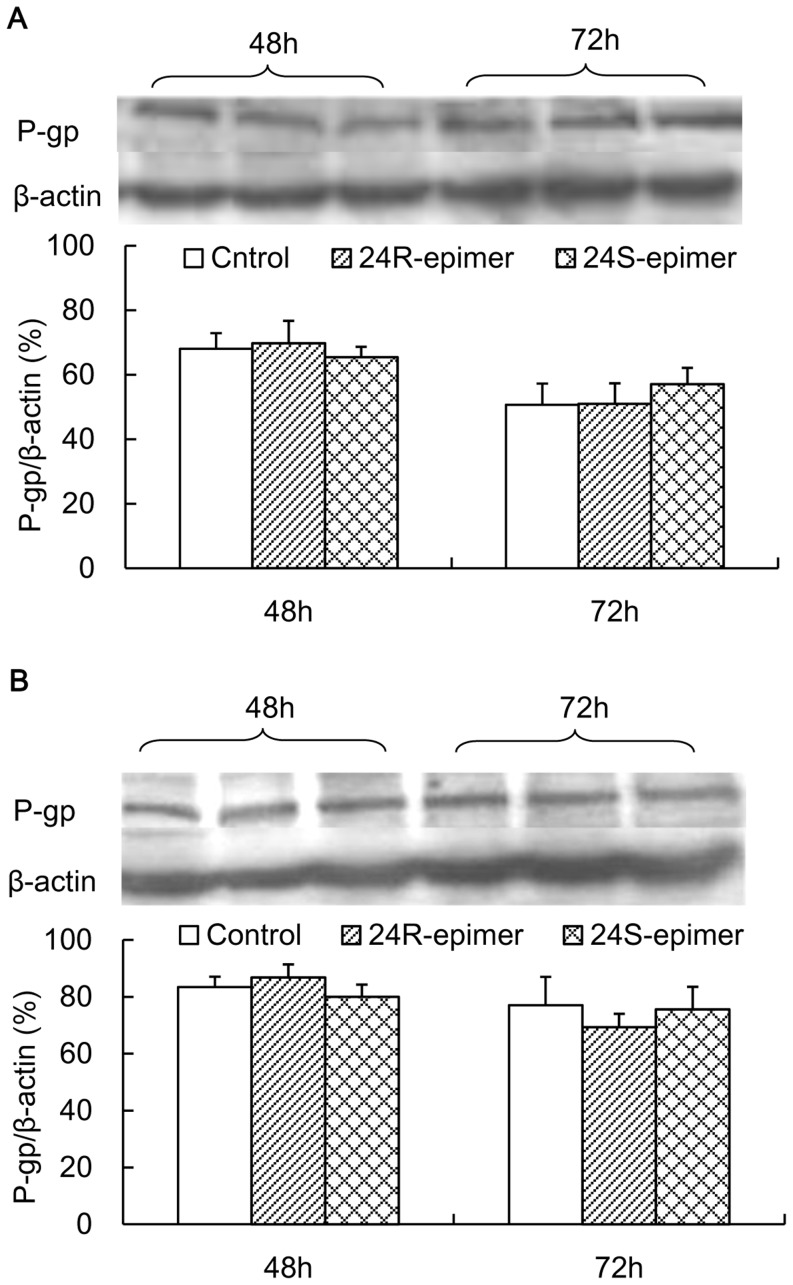
Effects of 24R-epimer and 24S-epimer on P-gp expression levels in Caco-2 cells.Cells were exposed to 24R-epimer or 24S-epimer at concentrations of 1 µM (A) and 10 µM (B), and 1% of DMSO as a solvent control for 48 and 72 h. The bar graphs show the P-gp protein band intensity corrected by that of β-actin.